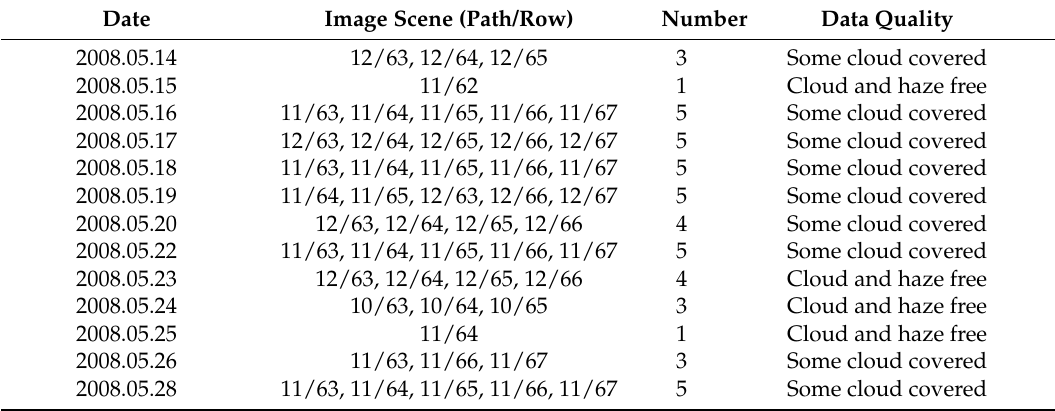
Table 3. The CBERS-02B CCD images used for the interpretation of geo-hazards